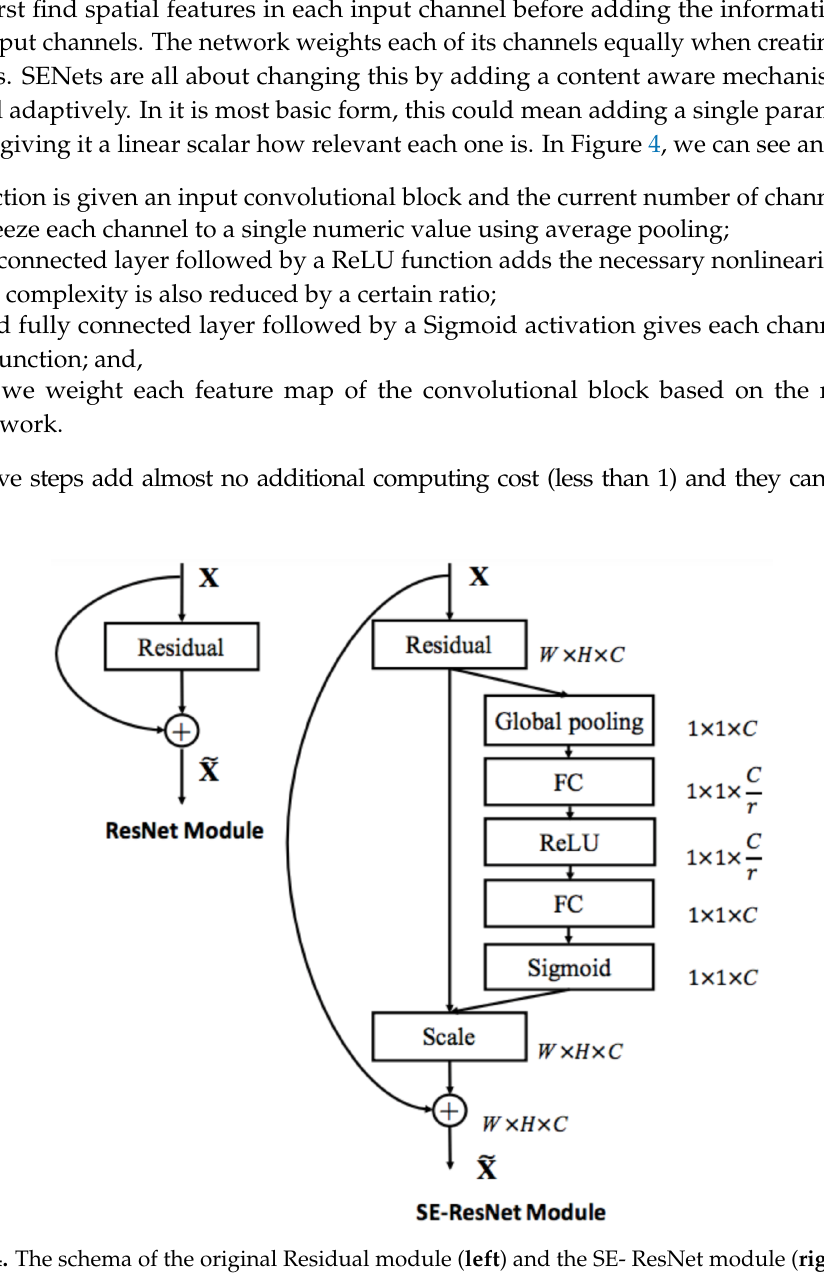
Figure 4. The schema of the original Residual module ( left ) and the SE- ResNet module ( right )